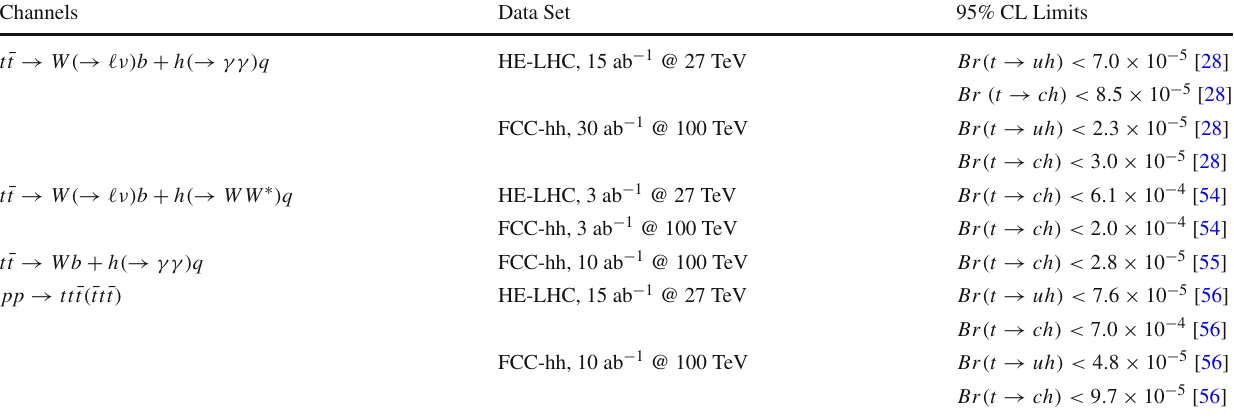
Table 5 The recent projected 95% CL limits on Br ( t → qh ) from different channels at the HE-LHC and FCC-hh